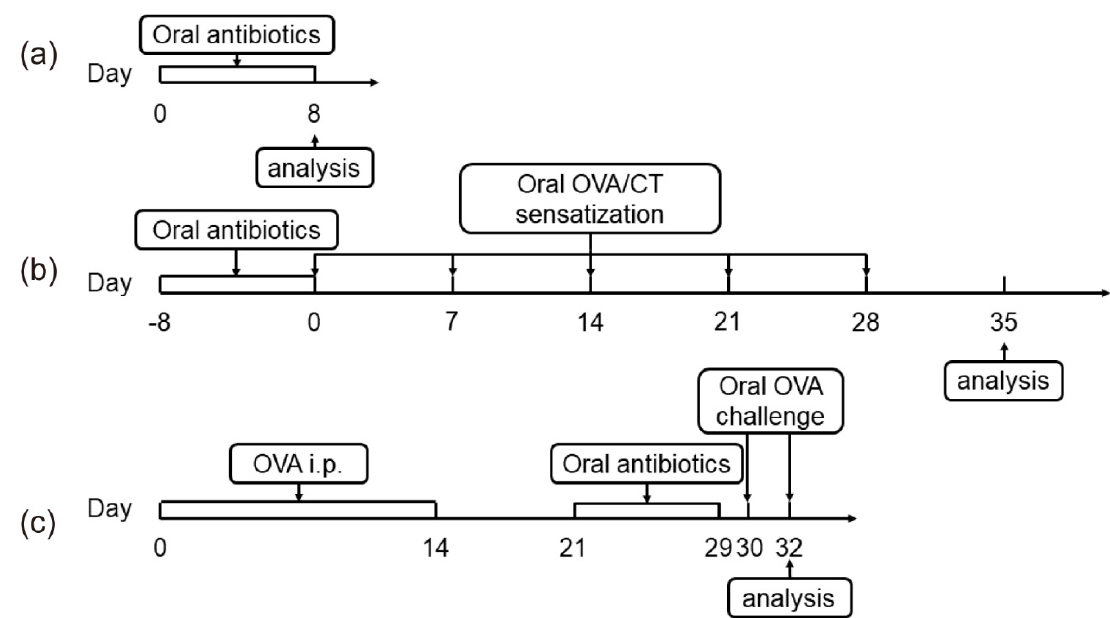
Figure 1. Methods of animal model establishment ( a ). Gut microbiota dysbiosis model ( b ). Gut microbiota dysbiosis-food sensitization model ( c ). Food allergy-gut microbiota dysbiosis model.